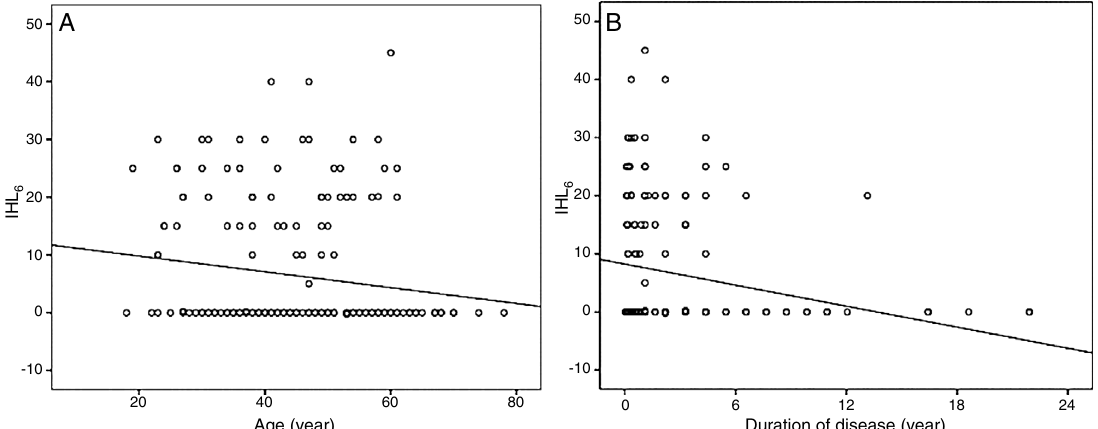
Figure 2 Simple scatterplots representing reverse correlations between patients’ age and improvement in the hearing level six months after treatment (IHL 6 ) (A) and between disease duration and IHL 6 (B). Contributors to hearing function after treatment